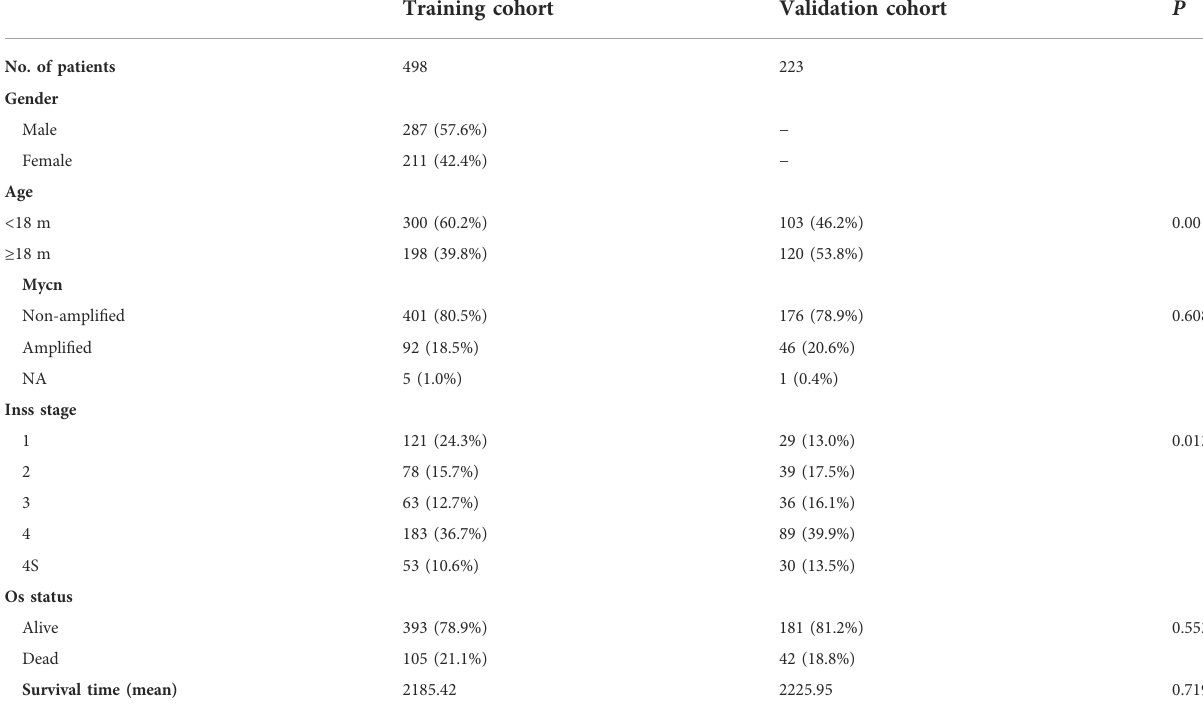
TABLE 1 Clinical characteristics of the two